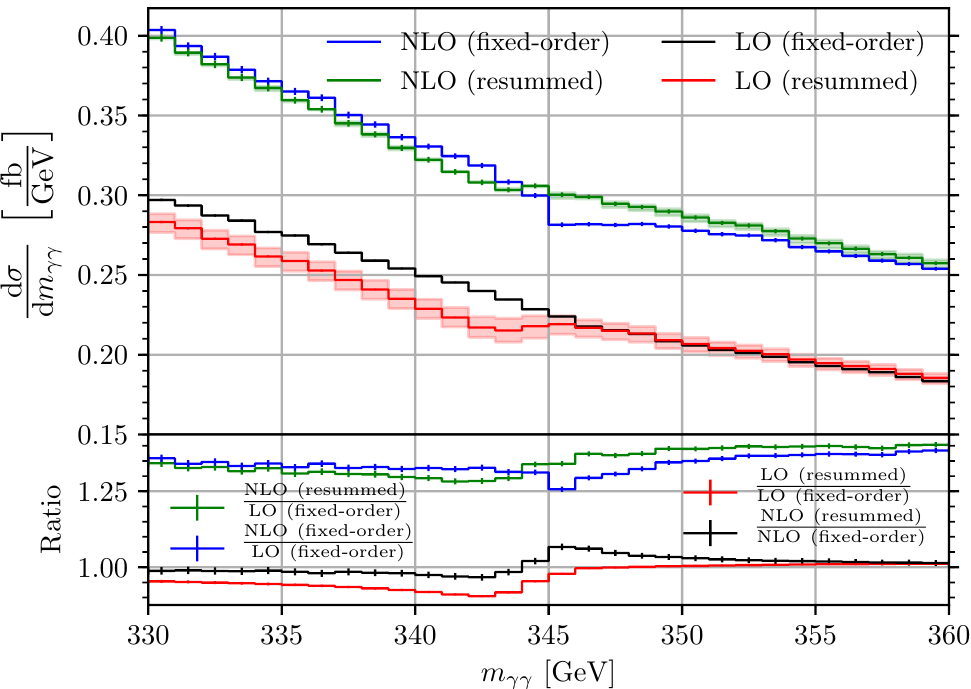
Figure 5. Zoom into the threshold region of the diphoton invariant mass distribution, comparing results with and without NRQCD. The shaded bands indicate the scale uncertainty by varying the scale (cid:22) by a factor of 2 around the central scale (cid:22) = 80 GeV. The renormalisation and the factorisation scales are set to (cid:22) R = (cid:22) F = m (cid:13)(cid:13) = 2 and not varied in this plot. The bars indicate uncertainties due to the numerical evaluation of the phase-space and loop